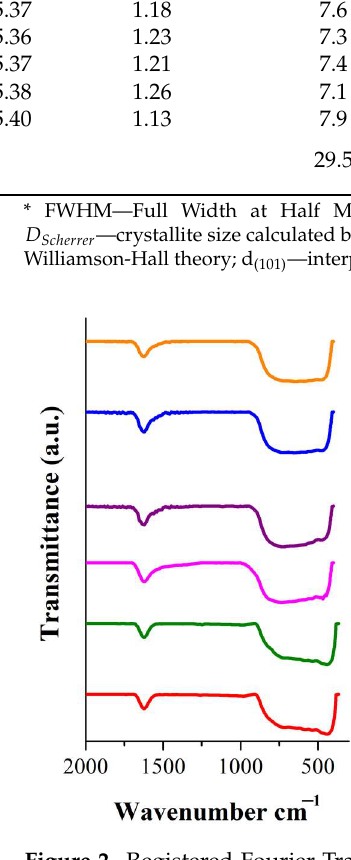
Figure 2. Registered Fourier-Transform Infrared (FTIR) spectra for TiO 2 samples synthesized by different ultrasonication regimes.